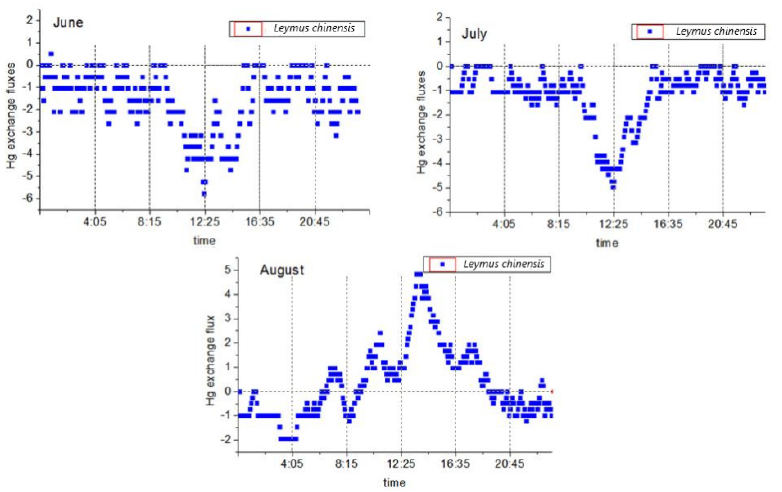
Figure 3. Changes in the daily mercury flux of Leymus chinensis during different months.